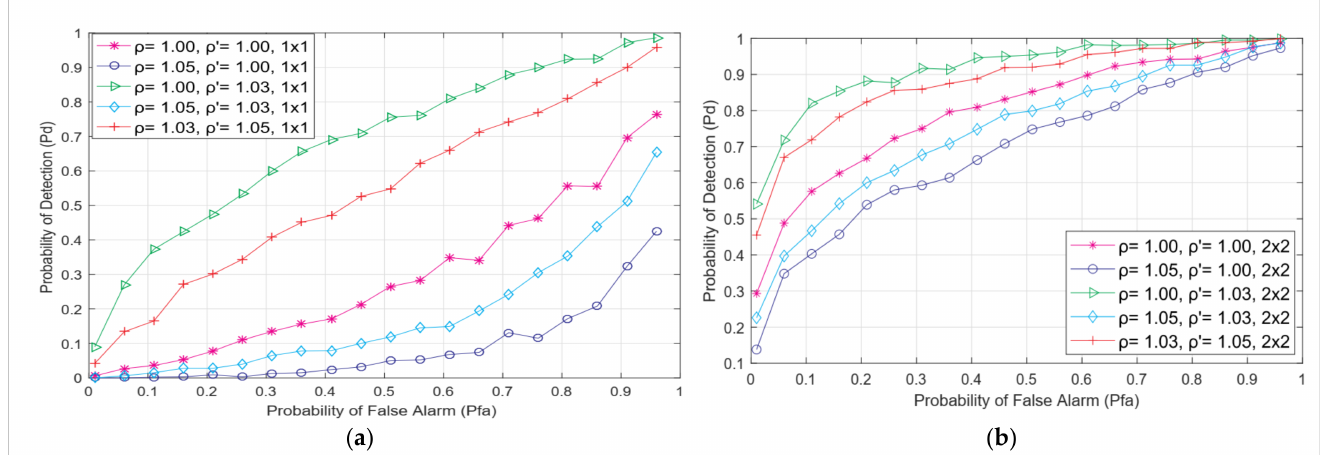
Figure 4. The ROC curves for various NU and DDT factor combinations in ( a ) SISO and ( b ) 2 × 2 MIMO-OFDM systems characterized by transmission with m-PSK/m-QAM modulation, N = 128, SNR = − 15 dB and P Tx = 100